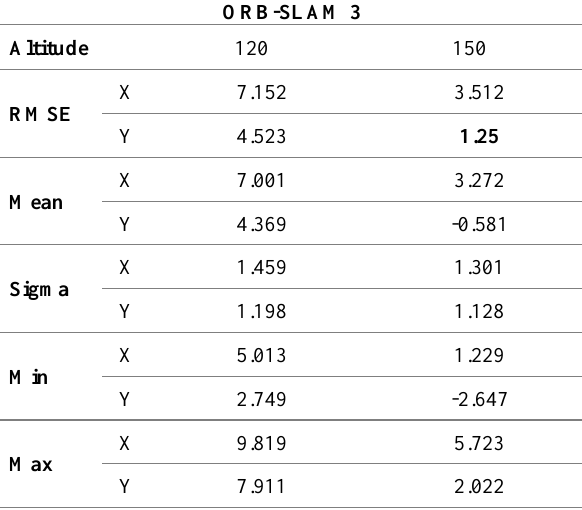
Table 6 Absolute accuracies of the orthomosaic processed with ORB-SLAM3 as the underlying framework. Entries in bold are dimension.